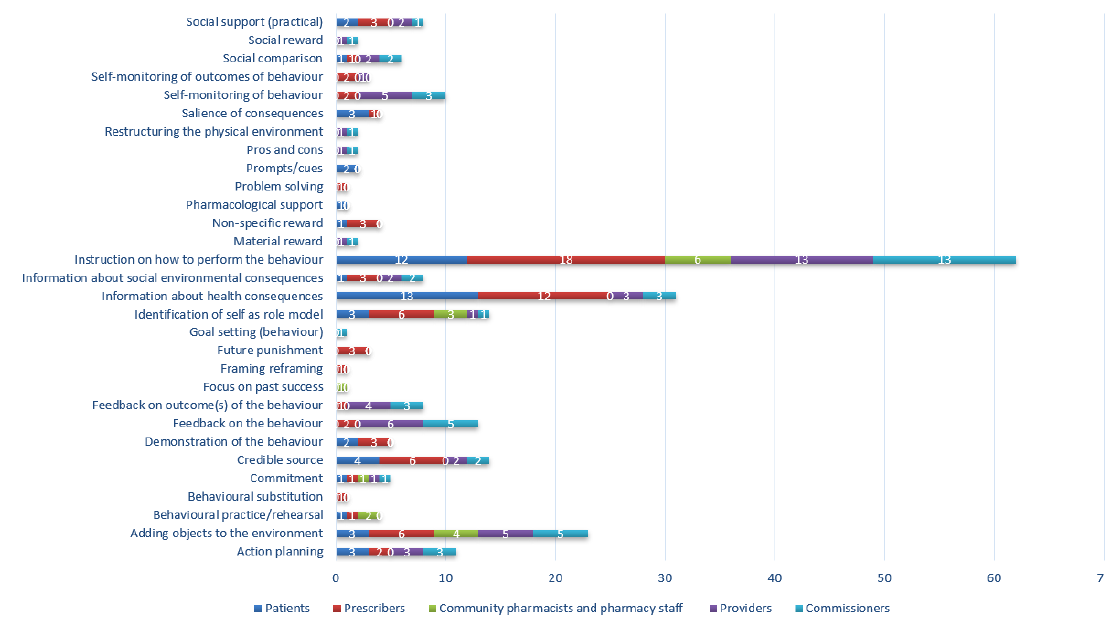
Figure 3. Frequency of identification of BCTs, by target group.